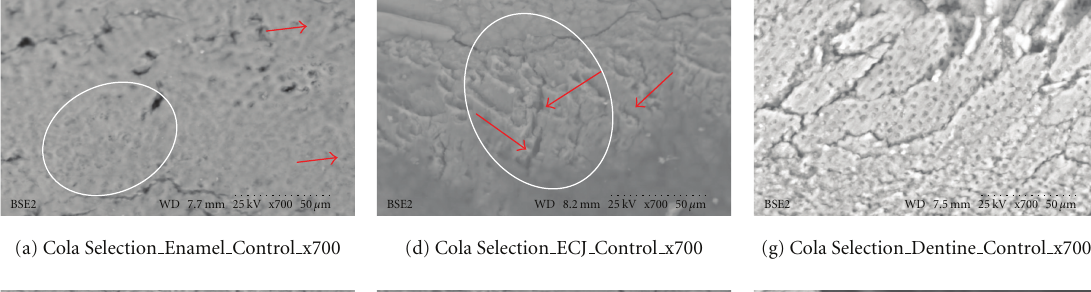
be derived from calcium ions secreted in stimulated